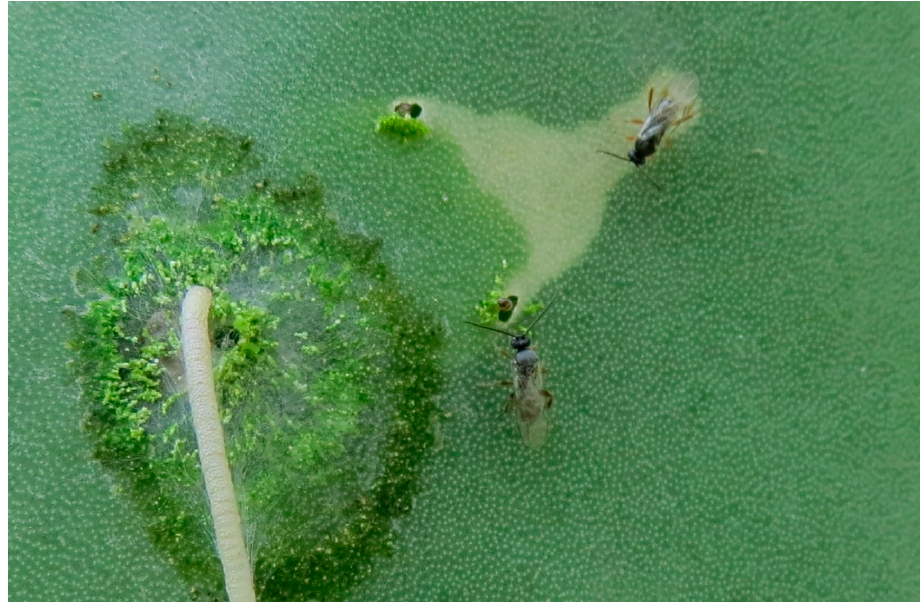
Figure 10. The parasitoid Apanteles opuntiarum (Hymenoptera: Braconidae) attacking first instar larvae of Cactoblastis cactorum .